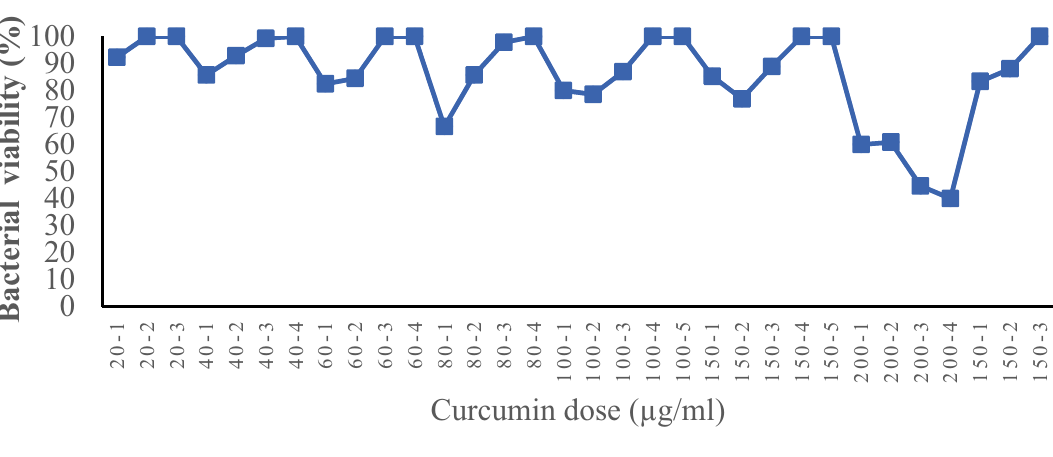
Figure 1. Adaptation of Lactobacillus plantarum to curcumin food